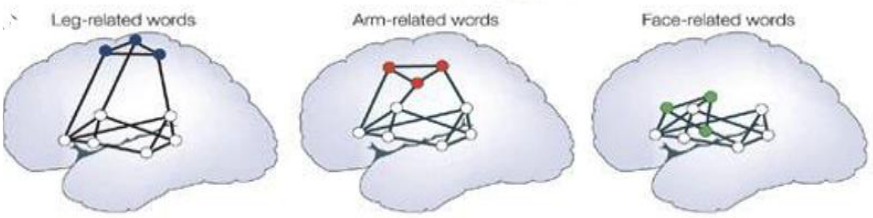
Figure 4. Multiple stream models of receptive language functions organized into multiple self-organizing simultaneously active networks. Grounded meaning indicates that the meaning of words and sentences are “ embodied ” [21,66].